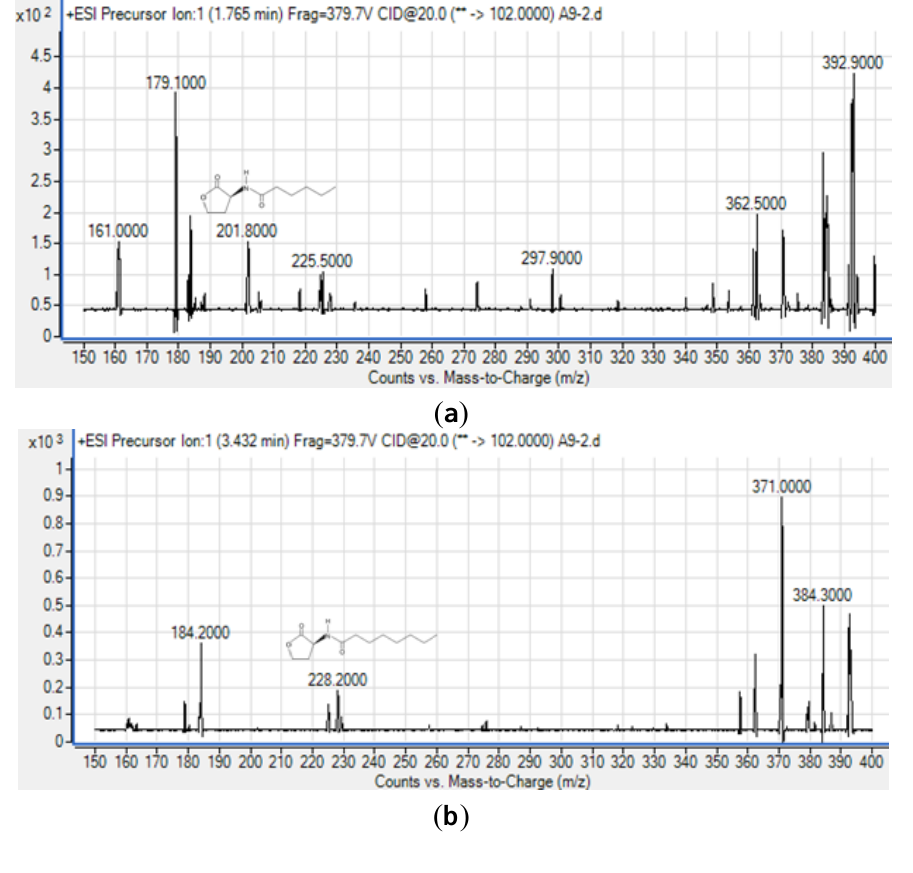
Figure 5. Identification of ( a ) C6-HSL ( m / z 201.8000) and ( b ) C8-HSL ( m / z 228.2000) from AHL extract of the spent culture supernatant of strain A9 by Triple Quadrupole